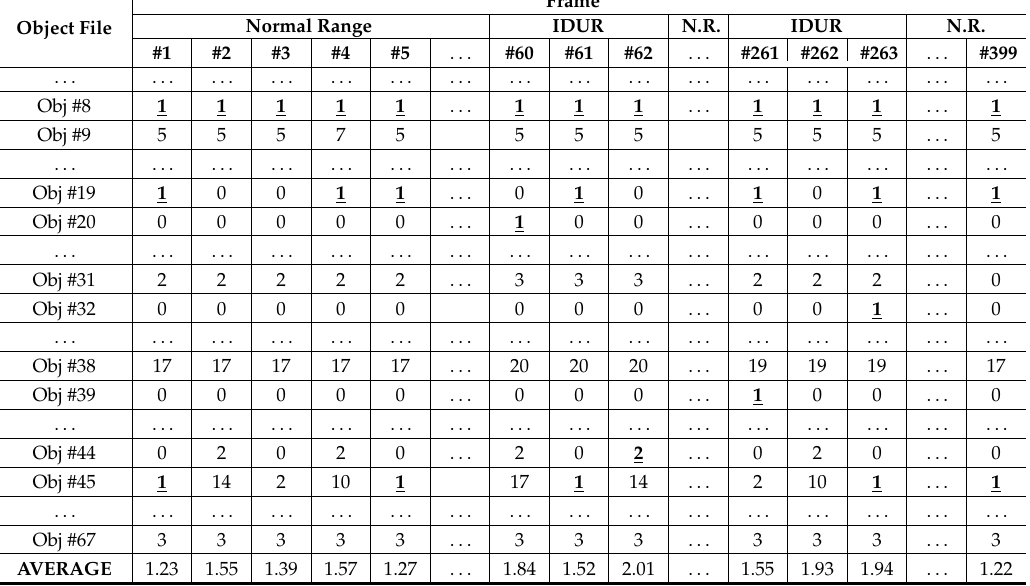
Table 2. Number of update addresses for each partition based on memory map (Test Case ID =